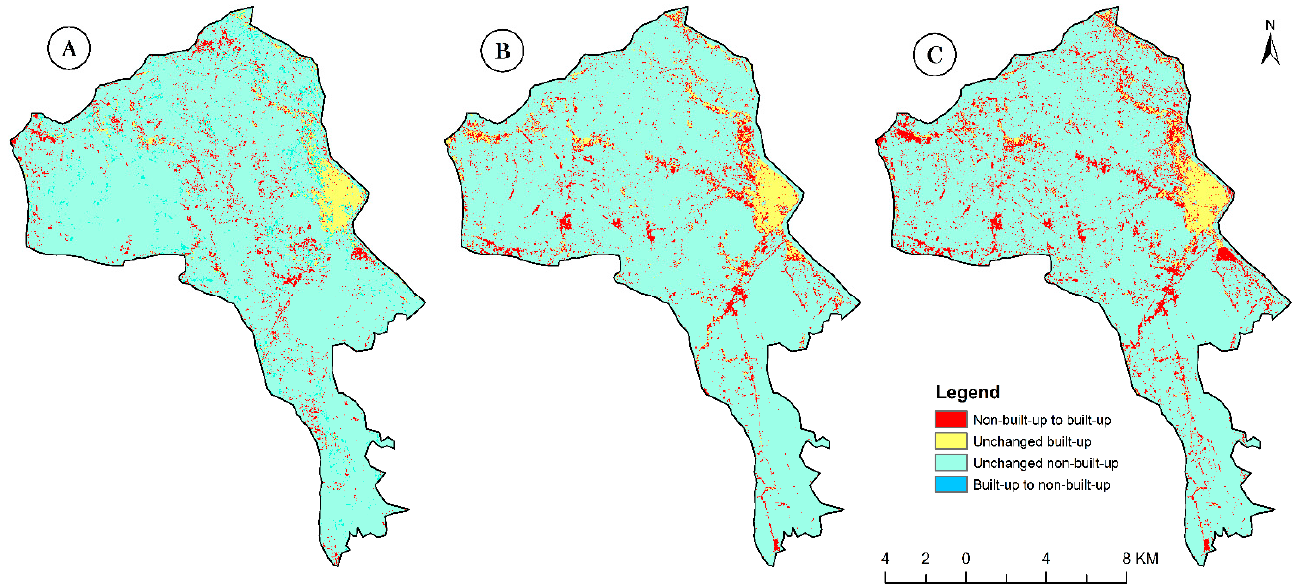
Figure 4. The LULC transition matrix using a heatmap between the periods of 2001 and 2021.